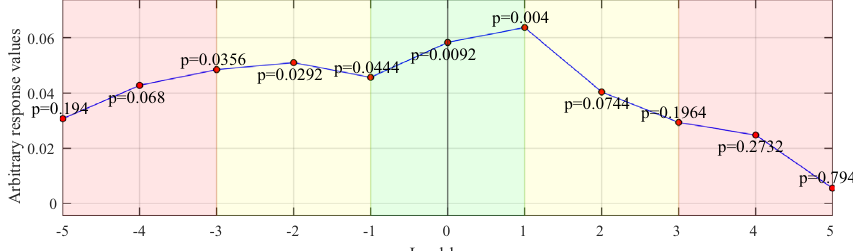
Fig. 2. Arbitrary response values on a temporal lead – lag x -axis (e.g. days). Every data point has also appointed a p -value. Different lead – lag intervals are shaded in different colors. Table 1. FDR based sorting of p -values for the whole interval in ascending order. n p